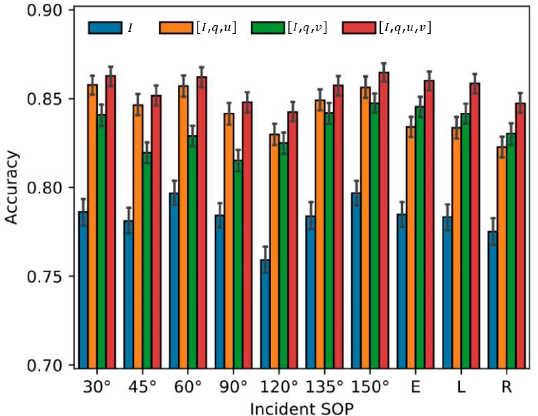
Figure 3. The performance comparison of different incident SOPs and different combinations of